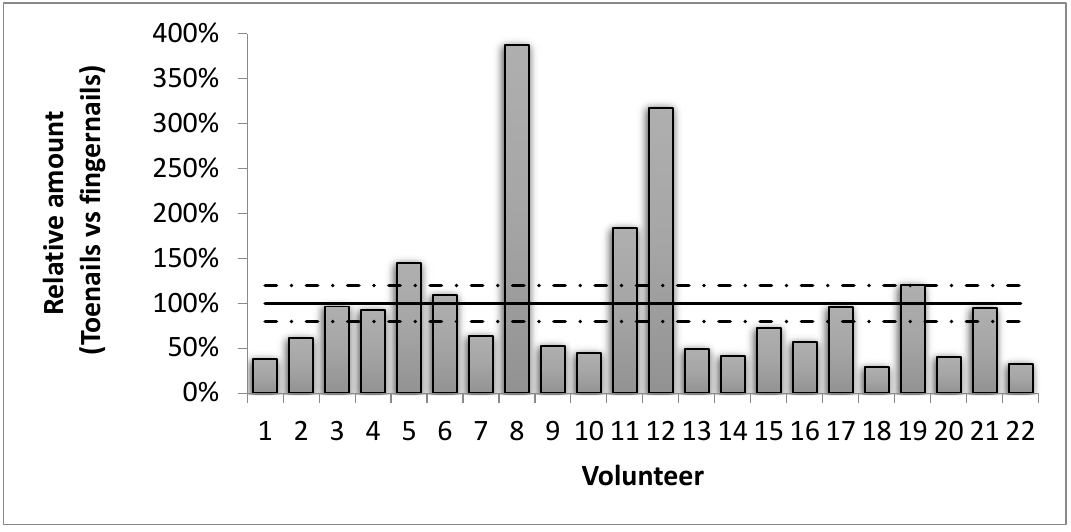
Figure 3. Toenail analysis failed to replace fingernails’ melatonin determination. Relative abundance of melatonin levels in toenails compared with the ones of fingernails collected at the same time from several volunteers. Dotted lines represent the 80–120% threshold required to consider the results as replaceable.